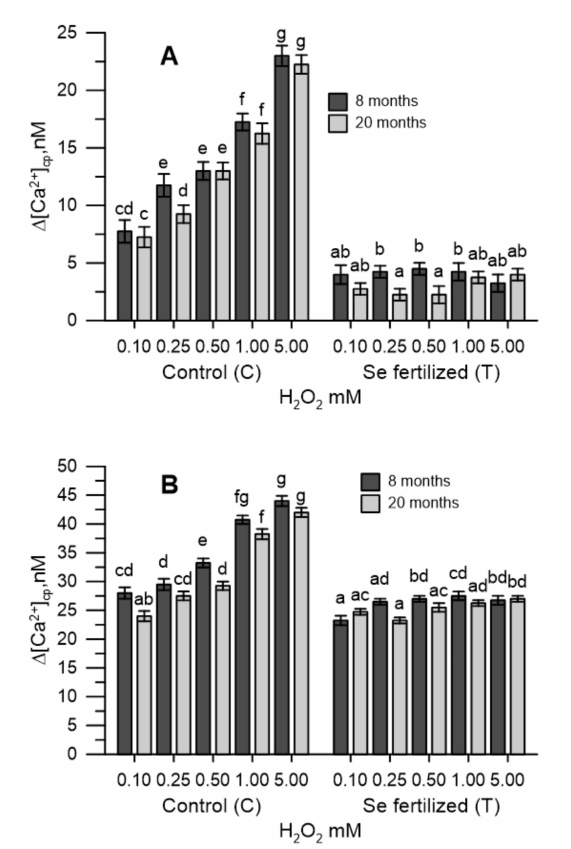
Figure 2. Effect of H 2 O 2 (0.1 to 5.0 mM) in the [Ca 2+ ] cp of pollen grains from untreated (C 8 and C 20 ) and Se-fertilized plants (T 8 and T 20 ). Measurements were performed in the absence ( A ) and in the presence ( B ) of CaCl 2 (1 mM) in the incubation medium. Data are expressed as means ± SEM from 4 independent tests. Different letters show significant difference at p < 0.05.